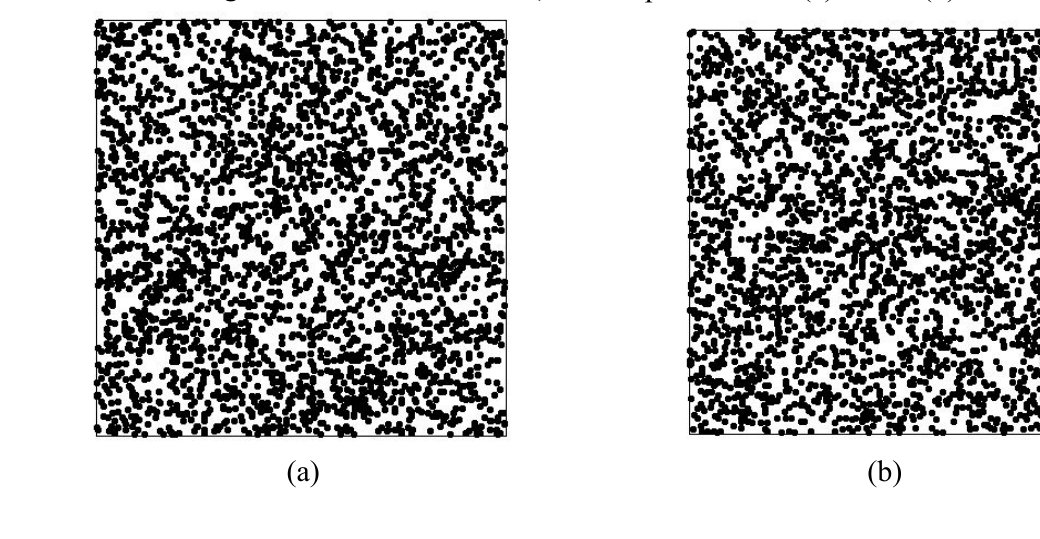
Figure 7. Locations of the 3,000 samples in areas (a) A and (b)